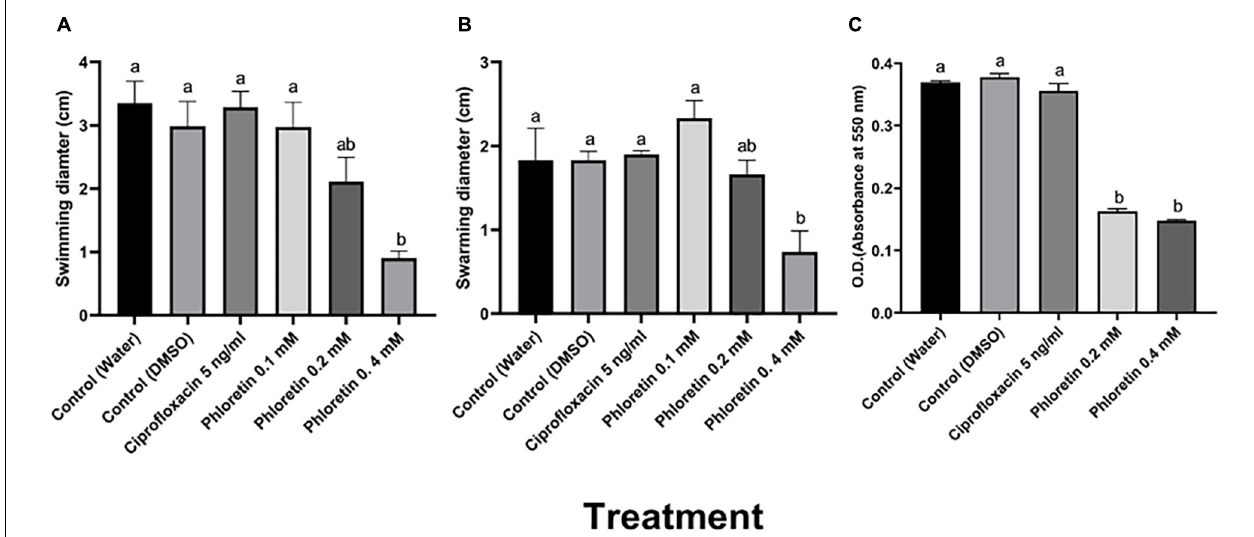
FIGURE 1 | Effects of non-lethal phloretin concentrations on (A) swimming motility, (B) swarming motility and (C) biofilm formation of Pectobacterium brasiliense (Pb1692). A dH 2 O treatment and a 0.3% DMSO treatment were used as controls. Bacteria were exposed to 0.1, 0.2, 0.4 mM phloretin or ciprofloxacin, 5 ng/mL (50% growth inhibiting concentration). The motility diameter was measured after 24 h. Bars that are not labeled with same letter are significantly different from each other ( P < 0.05; n = 16); Data represent the means ± SE of 2 independent experiments, each with 8 replicates. Biofilm formation was measured after 72 h of growth in LB medium at 28 ◦ C. Each bar represents the absorbance of crystal violet dye (bound to the biofilm cells) measured at 550 nm. Bars that are not labeled with the same letter are significantly different from each other ( P < 0.05; n = 12). One-way ANOVA and post hoc Tukey-Kramer HSD tests were used to analyze differences. The analysis was performed using GraphPad Prism 8.0. Data represent means ± SE of 2 independent experiments, each with 6 replicates.